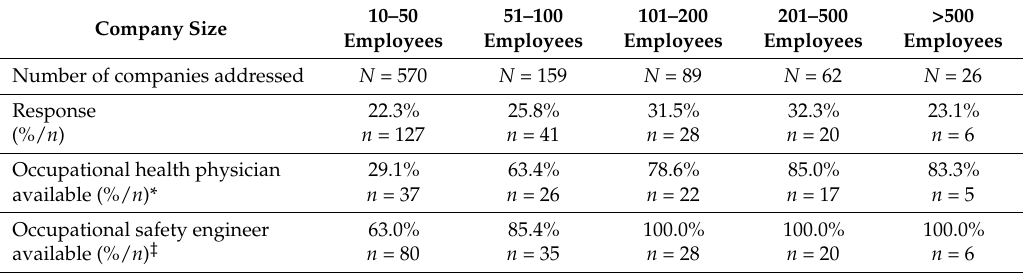
Table 2. Company characteristics of participating companies according to company size.